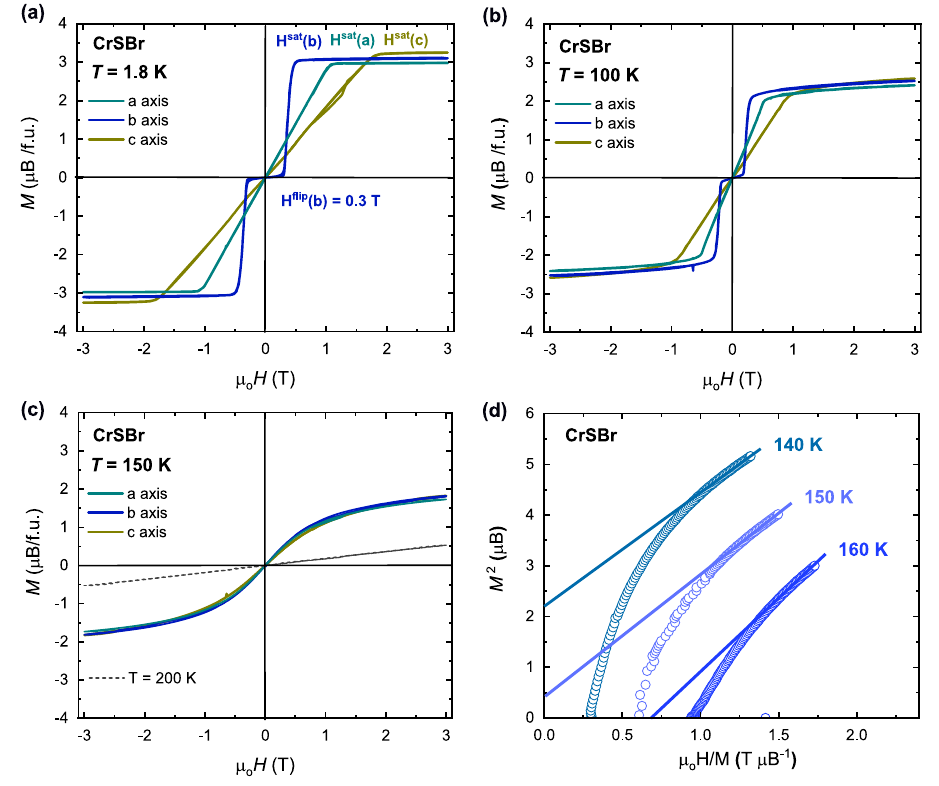
Fig. 3 | Field-dependent magnetizationofCrSBr. Isothermalmagnetization M ( H ) curves for a CrSBr single crystal at different relative orientations are shown for different temperatures in a – c showing the absence of magnetic anisotropy at